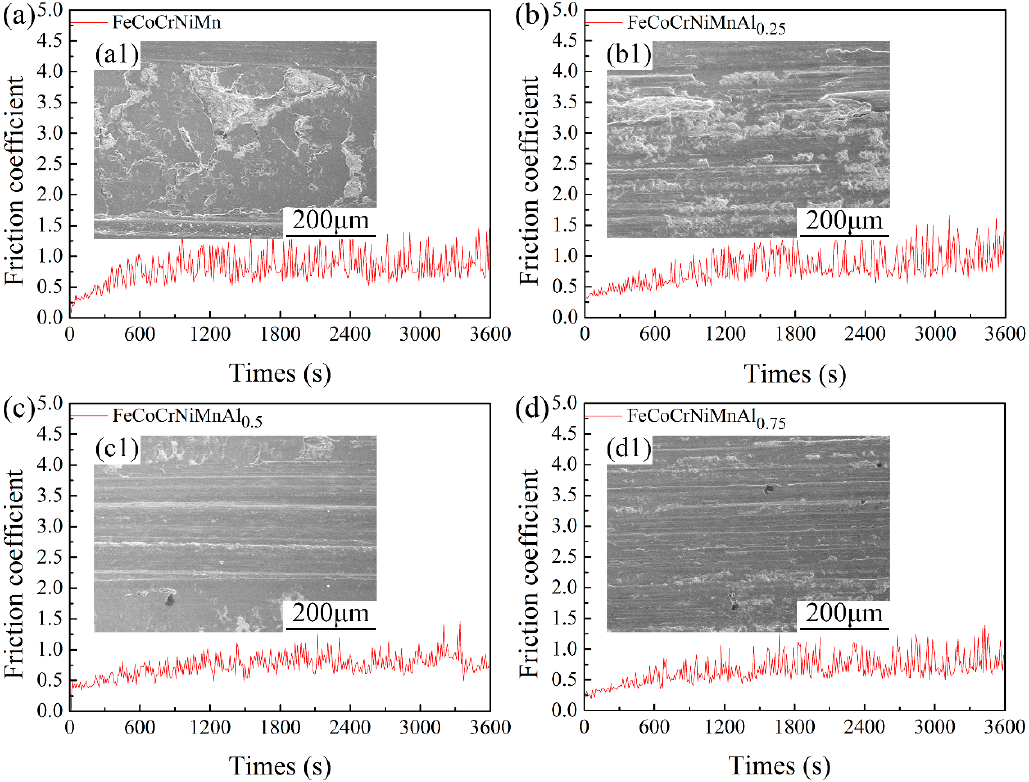
Figure 3. Friction coefficient curves and wear morphologies of the FeCoCrNiMnAl x cladding layers after 600 °C high-temperature wear tests: ( a , a1 ) x = 0; ( b , b1 ) x = 0.25; ( c , c1 ) x = 0.5; and ( d , d1 ) x = 0.75.